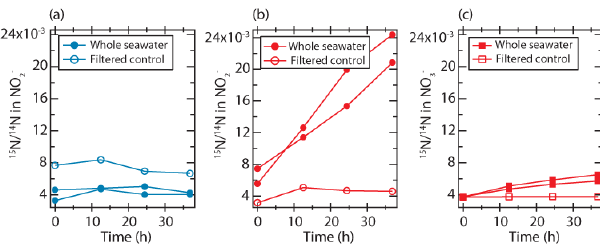
Fig. 4. Representative time course 15 N/ 14 N in NO − from 125m incubation at station 67.155 from (a) [ 15 N]O − and from (b) and (c) [ 15 N]H + and b ) have been corrected for carrier NO −